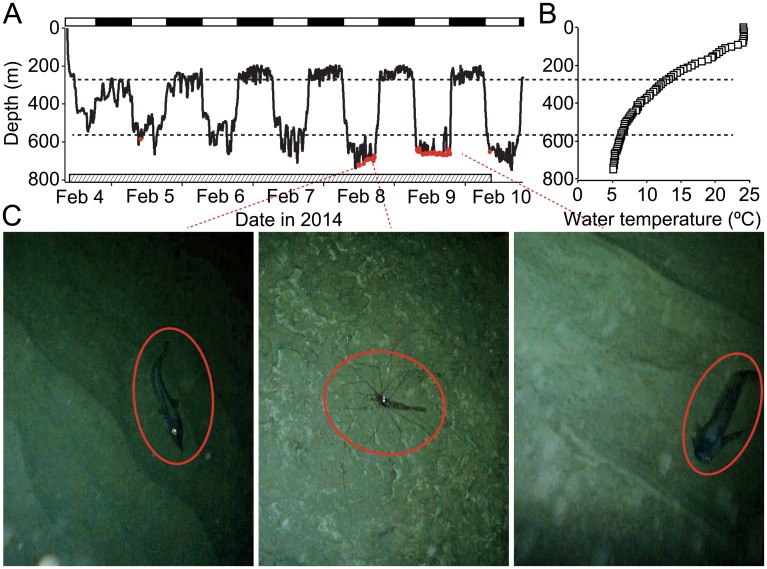
Diel vertical migration of a bluntnose sixgill shark.Time-series depth data (A) obtained from a male sixgill shark of 440 cm and vertical profile of water temperature (B). Black and white bars above the time-series depth indicate night and day, respectively. A shaded bar above the time axis shows operating time of the animal-borne camera. Dashed horizontal lines on the graphs indicate mean depth during daytime (568 m) and nighttime (279 m). Red markers in the depth record indicate that the seabed was visible in images captured by the animal-borne camera. (C) Examples of the seabed images with deep-sea creatures (red circles).